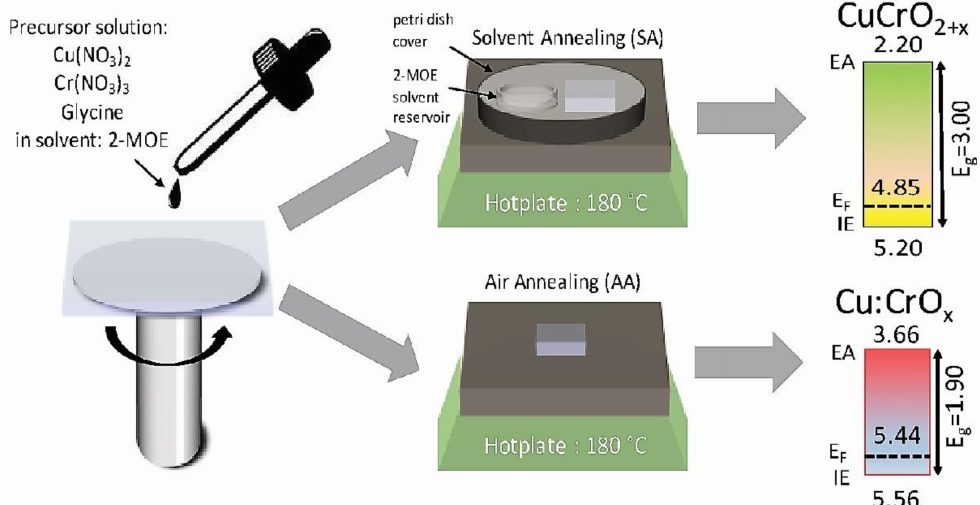
Figure 7. Schematic representation of the combustion synthesis. Adapted with permission from [194]. Copyright 2018, American Chemical